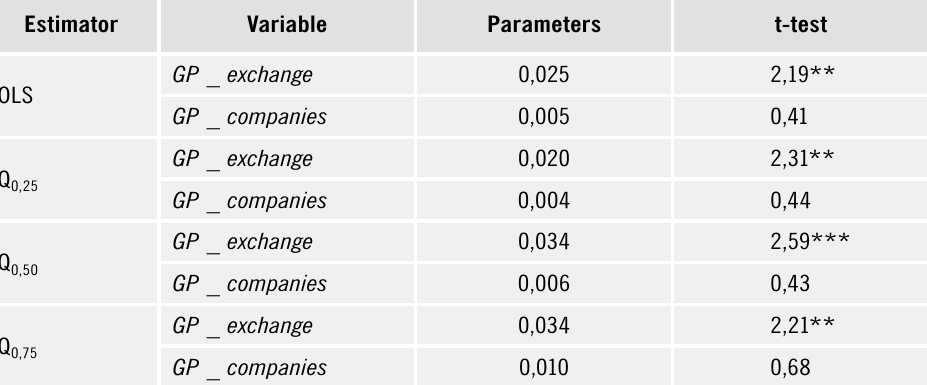
Table 8. OLS and quantile estimation of SDI multiple regression against GP _ exchange and GP _